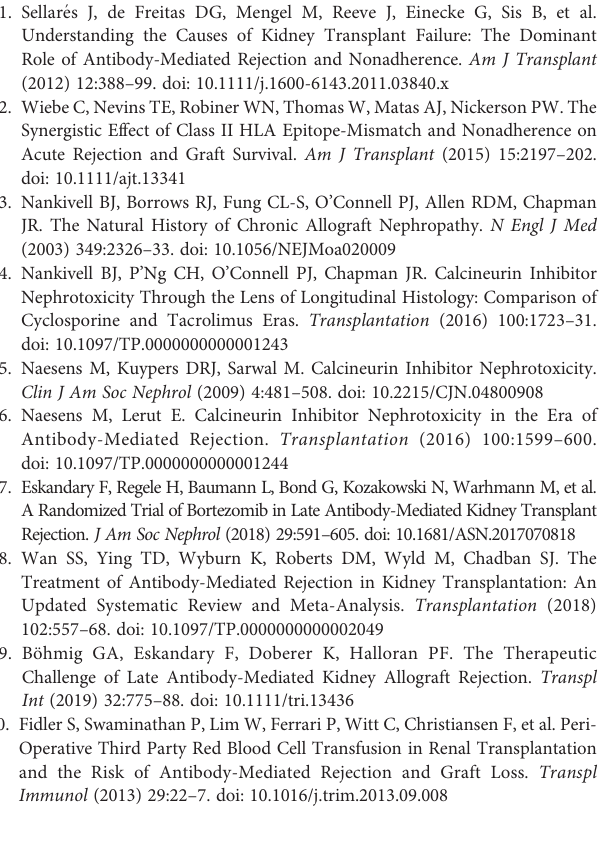
Supplementary Figure 1 | Comparison of dnDSA-free survival curves among the 4 groups de fi ned by EBT status (EBT- VS EBT+) and the induction strategy (Basiliximab [BAS] VS anti-thymocyte globulin [ATG]). dnDSA, de novo Donor Speci fi c Antibodies; EBT, Early Blood Transfusion (within 3 months post- transplantation). Supplementary Figure 2 | Comparison of dnHSA-free survival curves among the 4 groups de fi ned by EBT status (EBT- VS EBT+) and the induction